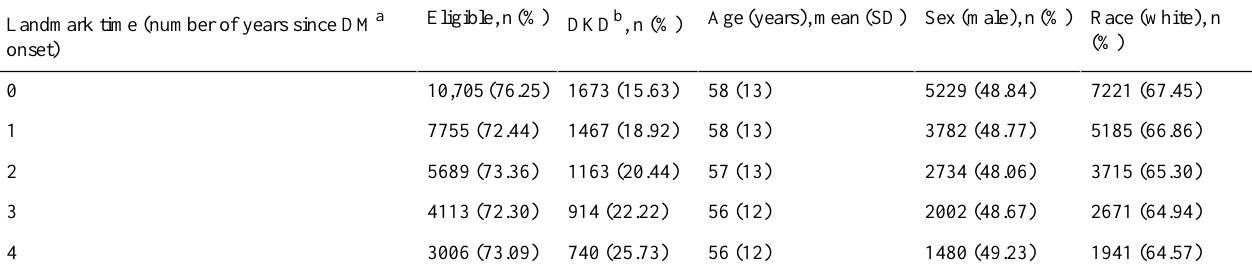
Table 3. Case-mix shift over landmark